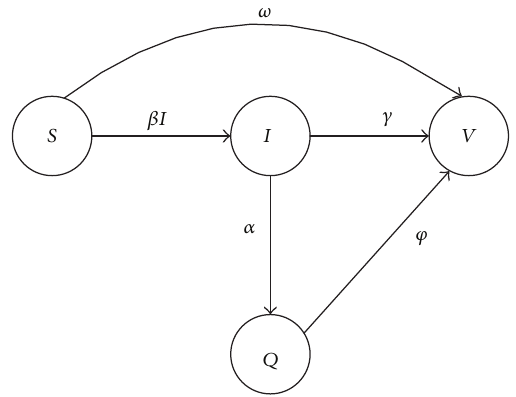
strategy should be taken into consideration. Firstly, infectious hosts are detected by the systems and then get quarantined and patched. Moreover, considering that hosts could get patched whatever state the hosts stay, we add a new path from hosts in susceptible state to vaccinated state to accord with actual situation. The state transition diagram of the worm propagation model with quarantine strategy is given in Figure